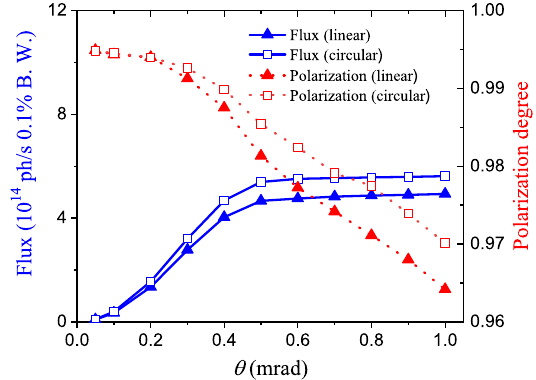
FIG. 10. The photon flux (solid blue) and polarization degree (dotted red) depend on pinhole radius at 7 eV for the linear mode (triangle symbol) and circular mode (square symbol) in the Knot